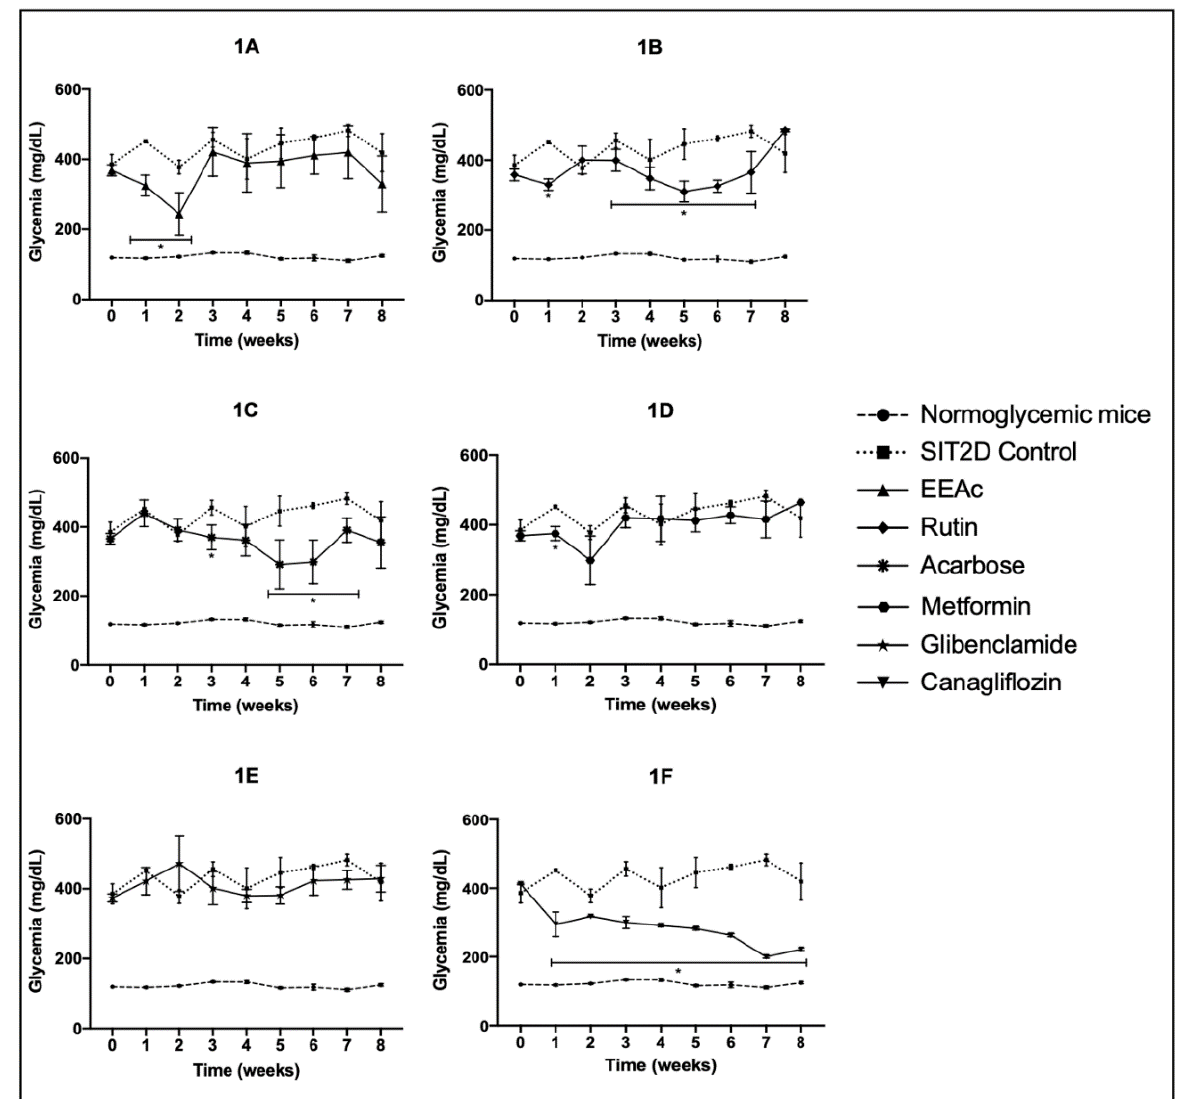
Figure 1. Effect over glycemic values of separate administration of the treatments in SIT2D mice compared with SIT2D and normoglycemic control groups. Groups treated with EEAc 300 mg/kg ( 1A ), rutin 50 mg/kg ( 1B ), acarbose 50 mg/kg ( 1C ), metformin 850 mg/kg ( 1D ), glibenclamide 5 mg/kg ( 1E ), and canagliflozin 50 mg/kg ( 1F ). Results are expressed as the mean ± SEM, n = 6, * p < 0.05 vs. SIT2D control at same week of treatment.